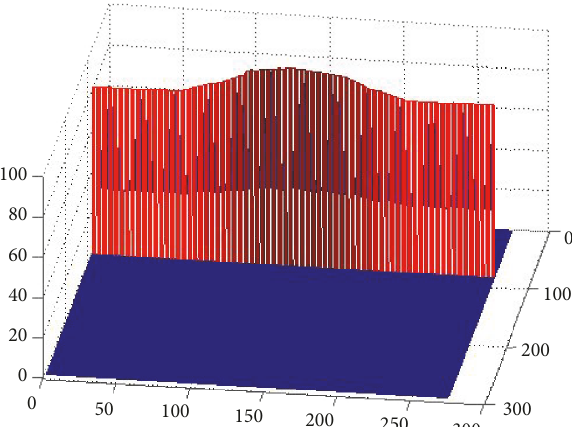
Figure 11: Highest height of reconstruction.